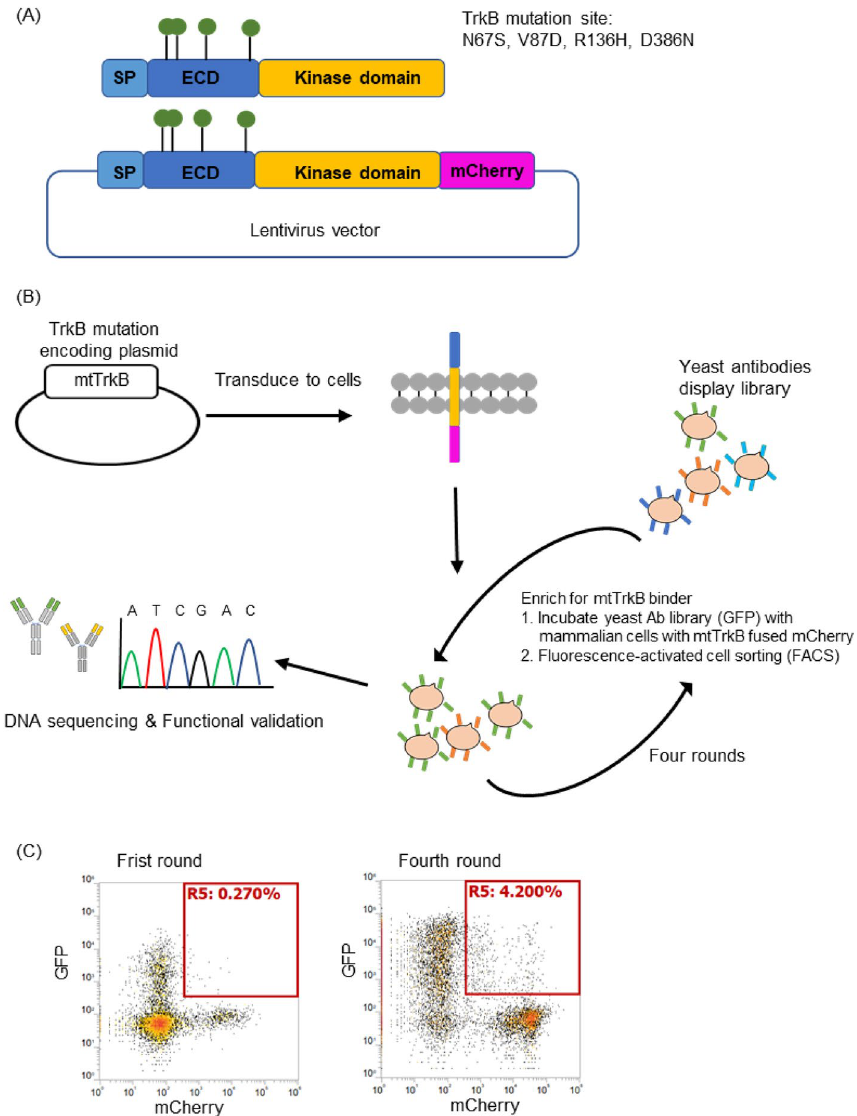
Figure 5. Schematic representation of the yeast display screening against mutated TrkB. ( A ) Schematic representation of the lentivirus expression plasmid encoding the mutated TrkB (mtTrkB) is shown. The four mutated TrkB site was located on extracellular domain (ECD) of TrkB. SP, signal peptide. ( B ) Yeast display was applied to select the four mutated amino acids of TrkB. A mtTrkB plasmid, which consists single or four mutated sites was created. The mtTrkB lentivirus plasmids were produced and transduce to 293 T to generate the overexpressed mtTrkB stable cell lines. The yeast surface display library was then subjected to selection for mtTrkB binding. Different variants antibodies were displayed on yeast cells. We used fluorescence-activated cell sorting (FACS) to enrich yeast cells that were able to interact with mtTrkB cell line. The post-selection pool was then expanded and subjected to another round. Four rounds of selection were performed. Variants that were able to bind to the mtTrkB cell lines would enrich in occurrence frequency throughout the screening process. The post-selection yeast antibodies libraries were sequenced and further expressed to confirm the cell binding of mtTrkB cell lines. ( C ) Yeast library was enriched by round 4 against mutated TrkB cell